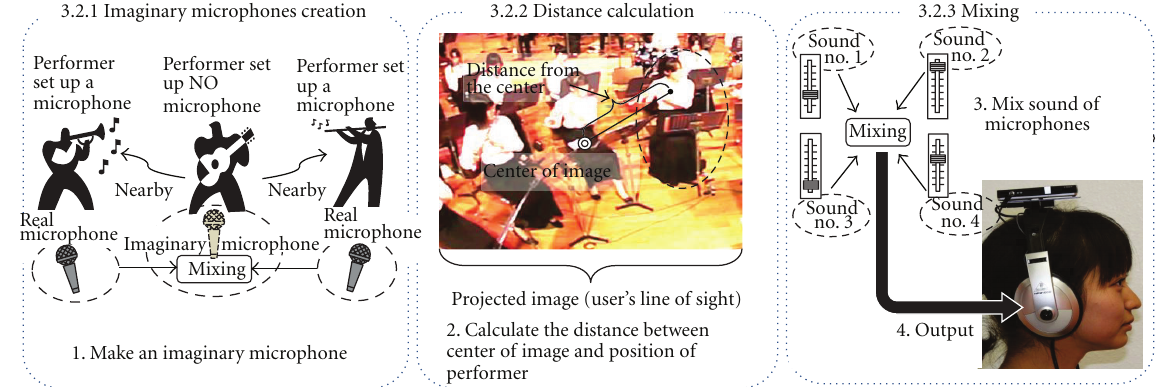
Figure 12: Audio processing system.